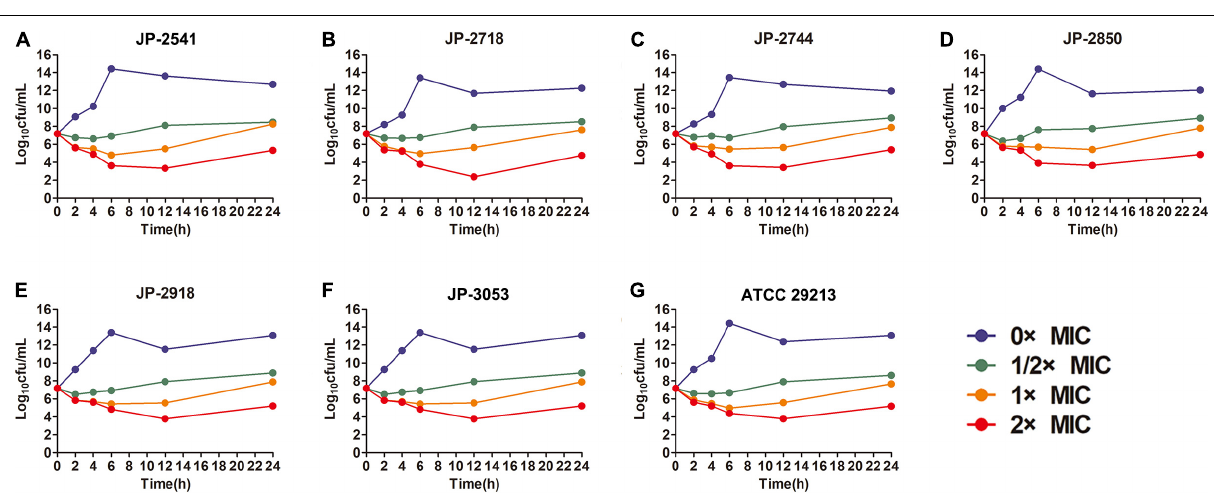
FIGURE 1 | Effects of different concentrations of CDB on the growth of Staphylococcus aureus. (A) growth curves for JP-2541; (B) growth curves for JP-2718; (C) growth curves for JP-2744; (D) growth curves for JP-2850; (E) growth curves for JP-2918; (F) growth curves for JP-3053; and (G) growth curves for S. aureus ATCC 29213.